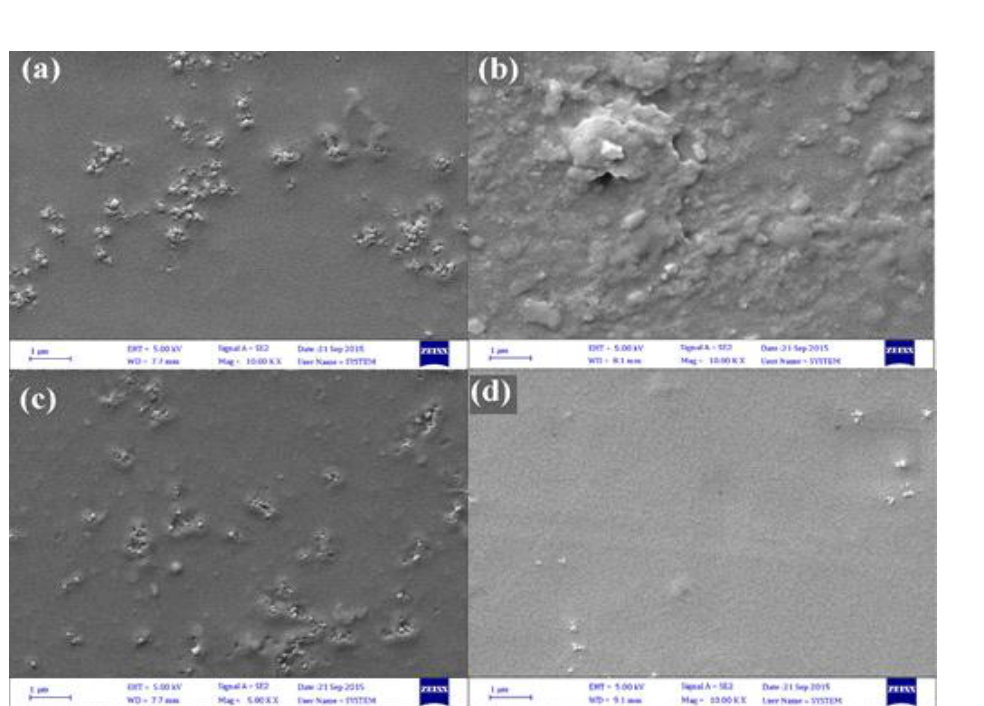
Fig. 1. SEM images of A2, A3, A4 and A5